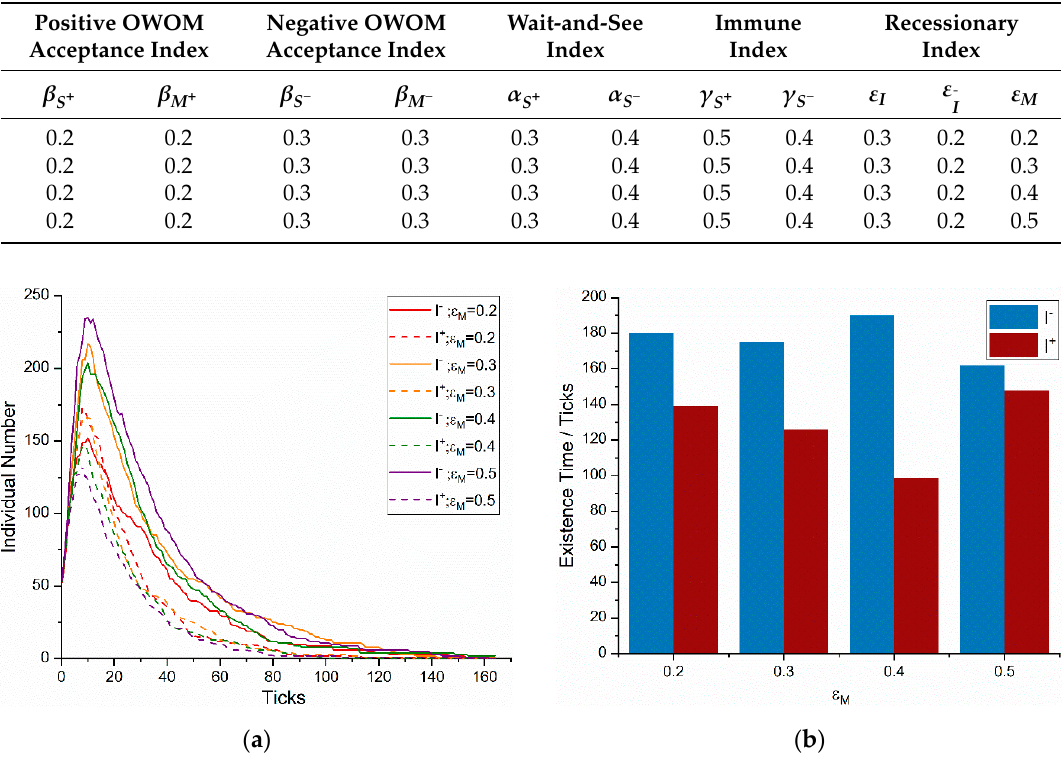
Figure 9. Brand OWOM communication effect when the brand observers’ recessionary conditions are different. ( a ) The individual number of brand advocators and protesters; ( b ) the existence time of positive and negative OWOM.